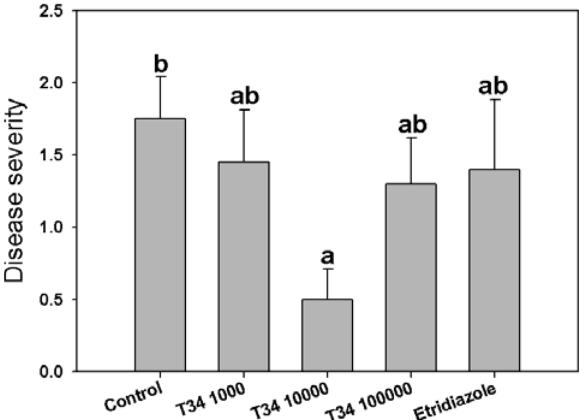
Figure 1 . Disease severity produced by Phythophthora cap- sici in pepper plants on the last day of the growth cham- ber experiment (21 d after inoculation with the pathogen). Disease severity was scored using the following symptom scale: 0, healthy plant; 1, less than half the leaves wilted; 2, more than half the leaves wilted; and 3, dead plant. Control, water; T34 1,000, 10,000 and 100,000, Trichoderma asperellum strain T34 at 10 3 , 10 4 and 10 5 conidia mL -1 ; Etridi - azole, Terrazole ® at 2 L ha -1 . All the plants were inoculat- ed with P. capsici . Treatments were applied 7 d before the pathogen and a second treatment of biocontrol agent was applied upon detection of symptoms of disease. Different letters indicate significant differences within treatments, Duncan’s multiple range test ( P